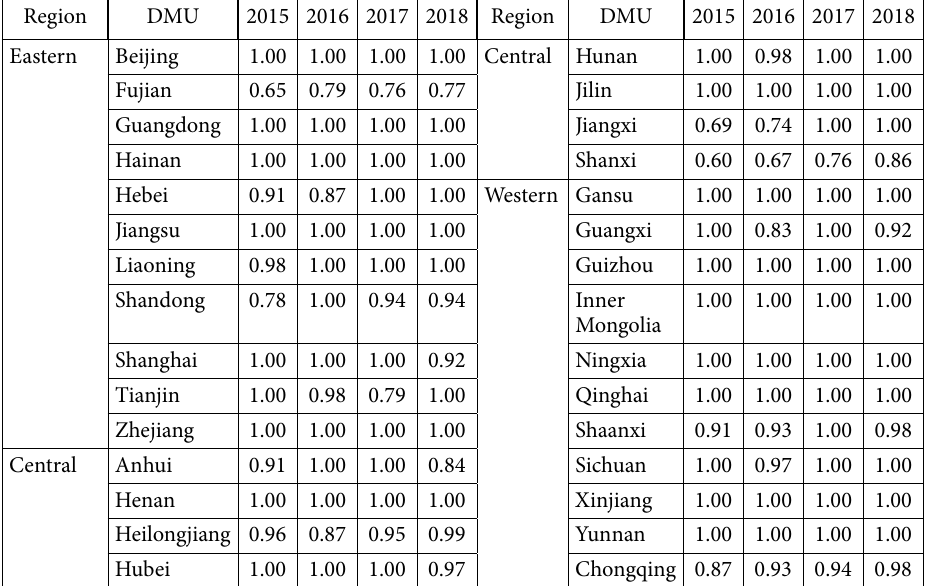
Table 7. Technology innovation efficiency from 2015 to 2018 Region